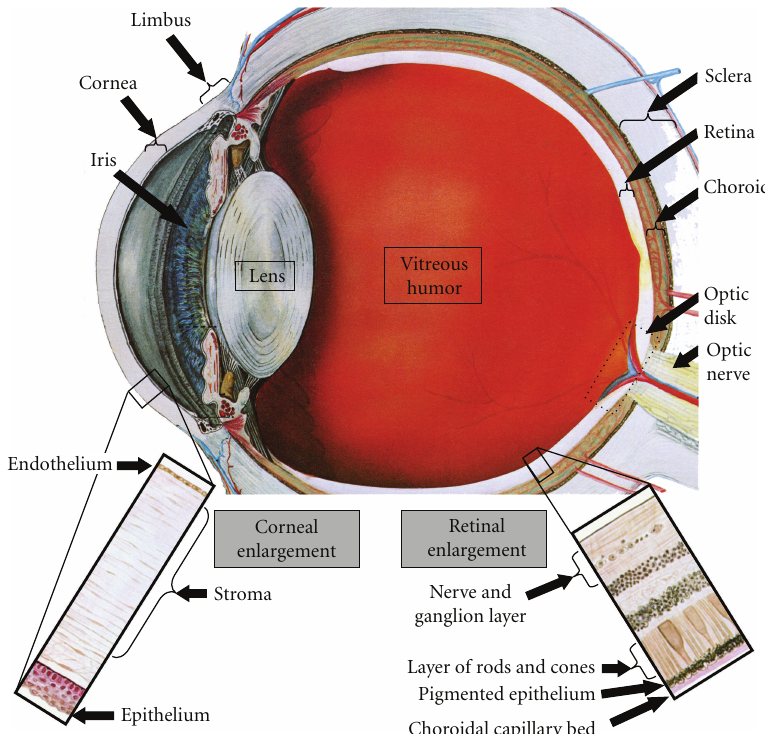
Figure 5: PPAR γ is broadly expressed in the eye providing a pharmacological target for treating ocular angiogenesis. PPAR γ expression is found in the retina including RPE cells, REC, pericytes [287], and ganglion cells. In the cornea, PPAR γ is most prominently localized in the epithelial and endothelial layers. Excessive angiogenesis is a pathological hallmark of a number of eye diseases, and anti-VEGF/VEGFR strategies are used therapeutically to treat ocular neovascularization. Manifestations of hematological malignancies in the eye have been documented for leukemia, lymphoma, and multiple myeloma. The potential benefits of PPAR γ agonist therapy to inhibit tumor-associated angiogenesis could also be applied to treatment of neovascular eye